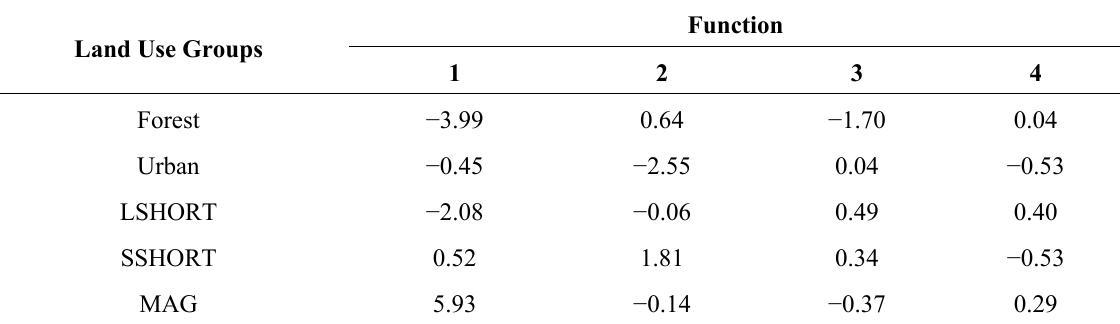
Table 3b. Functions at group